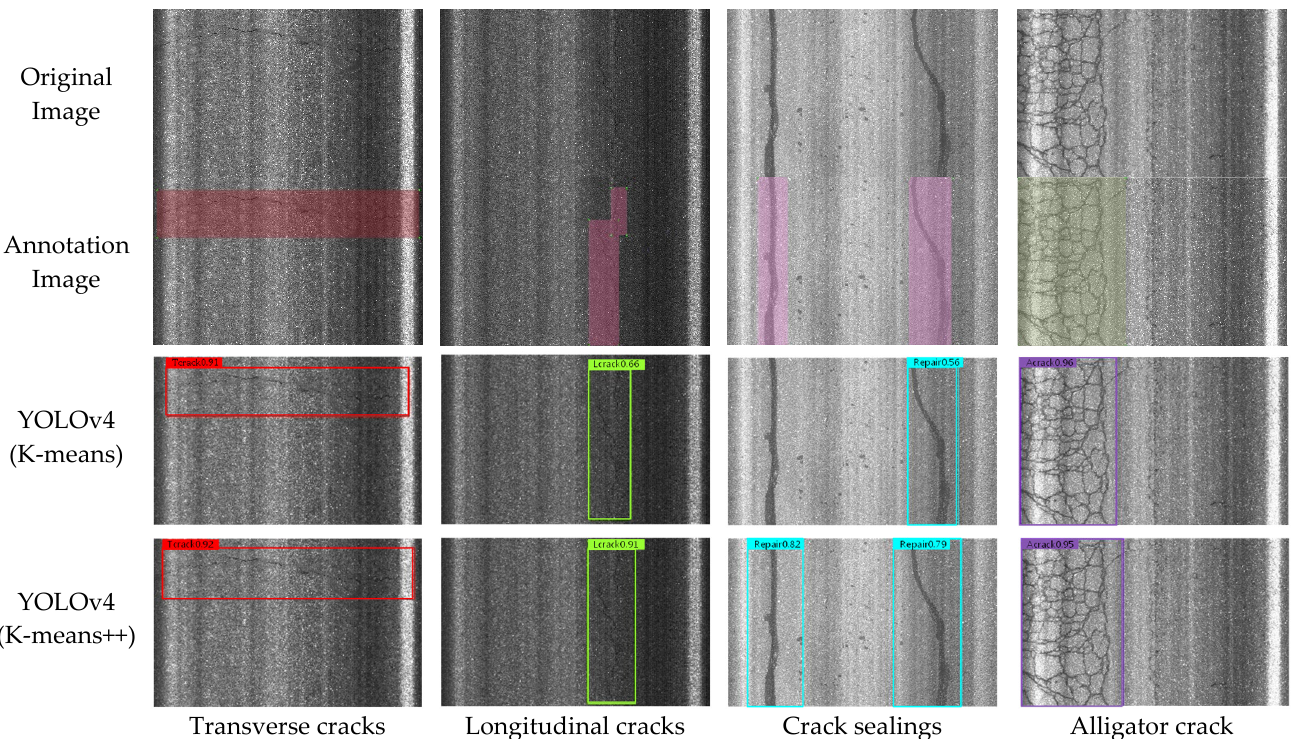
Figure 9. Detection effect of YOLOv4 (K-means) and YOLOv4 (K-means++).